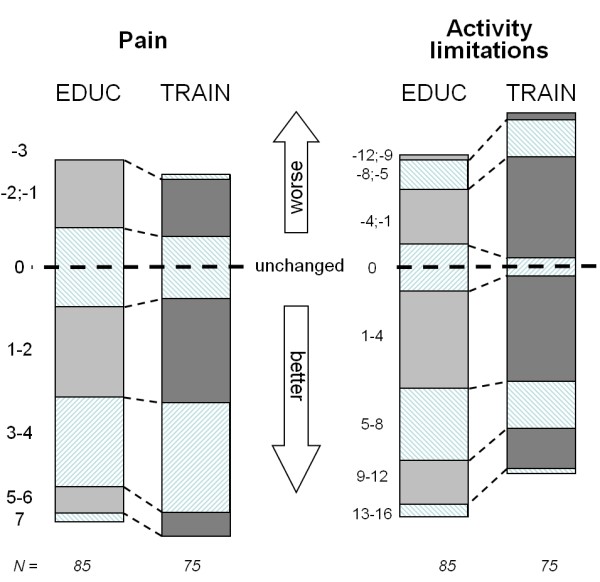
Reduction in 'pain' and 'activity-limitation' scores from baseline to 12 months, presented by group. E.g. (bottom left): 6 EDUC-treated patients (= grey column, numbers given by height as % of total height = 85 patients) obtained a pain reduction of either 5 or 6 compared with 5 of those in the TRAIN group. A reduction of 7 was only obtained by 2 EDUC-treated patients (lowest left area). Upper part = neg. improvement = more pain.